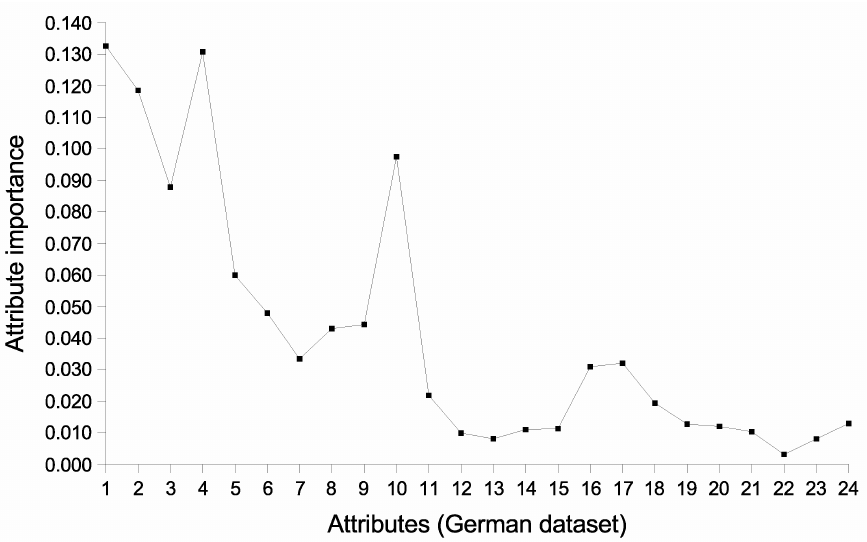
Figure 4. Relative importance of attributes predicted by boosted decision trees for the German